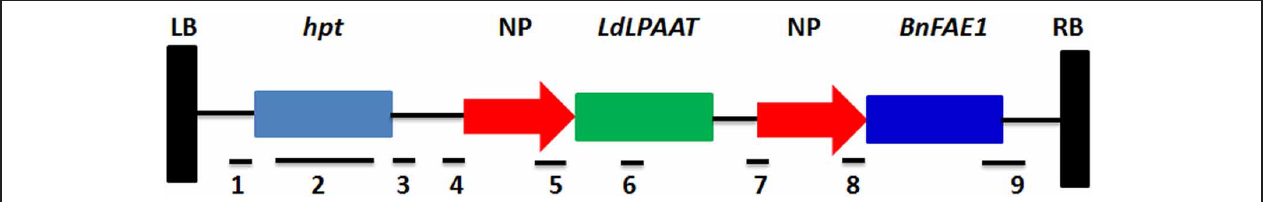
Sma I, Bam HI, Xba I, Sal I, Bam HI, Eco RV; 5: Eco RV, Eco RI; 6: Bam HI; 7: Xba I, Eco RV; 8: Eco RV, Eco RI, Hin dIII; 9: Hin dIII, Sal I, Pst I. LB, left border; hpt , hygromycin gene; NP, napin promoter; RB, right